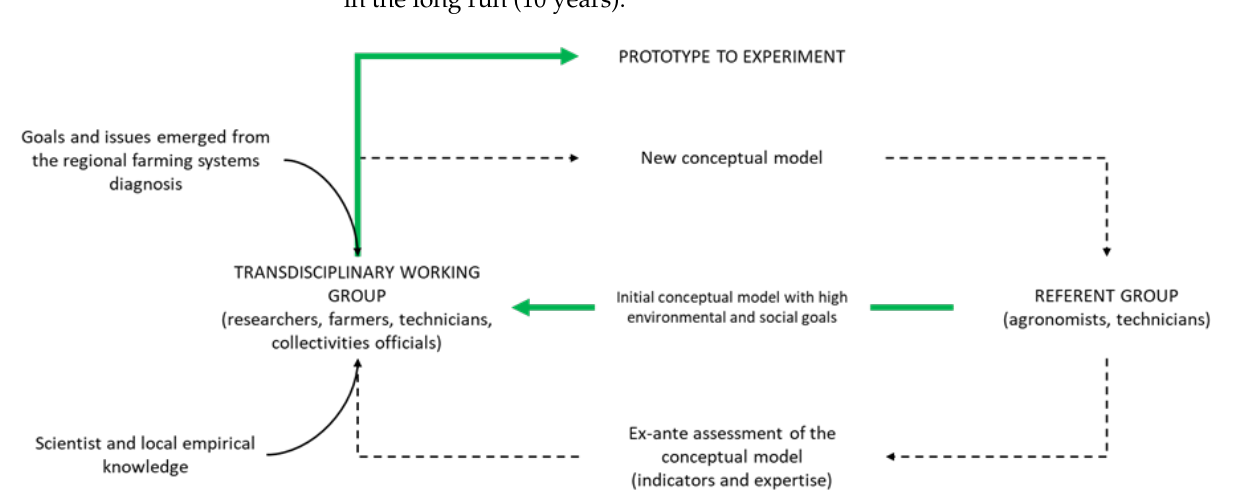
Figure 1. Progress of the farming system design (step 3). This co-design framework was aimed at developing the conceptual model of a climate-smart microfarm using AE principles/practices (solid arrows: integration of tools and data, dashed arrows: iterative improvement, green arrow: initial and final prototypes).